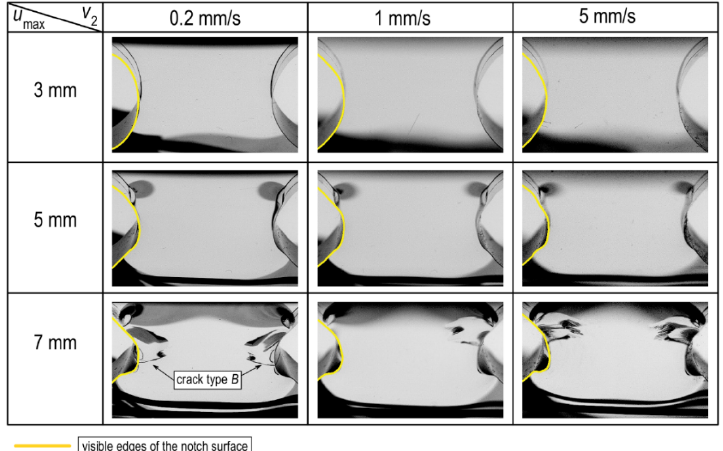
Figure A4. Deformation in the U-notched specimens ( t 2 ) after the unloading for u max = 3, 5, and 7 mm and (cid:2013)̇ (cid:2870) 8 × 10 −3 , 4 × 10 −2 , and 2 × 10 −1 s −1 .